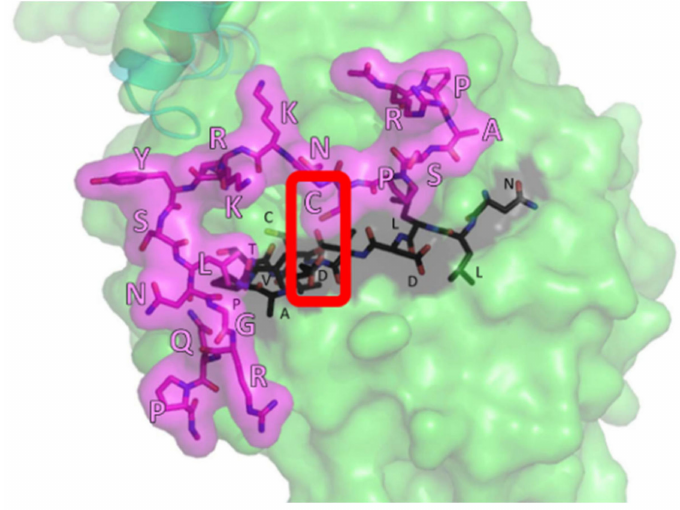
Figure 3. Putative three-dimensional structure of calcineurin A (CNA; green) and NFATc1 (pink) complex. The amino acids essential for the complex formation between NFATc1 (Cys263) and CNA (Asp82) are indicated by the red frame.